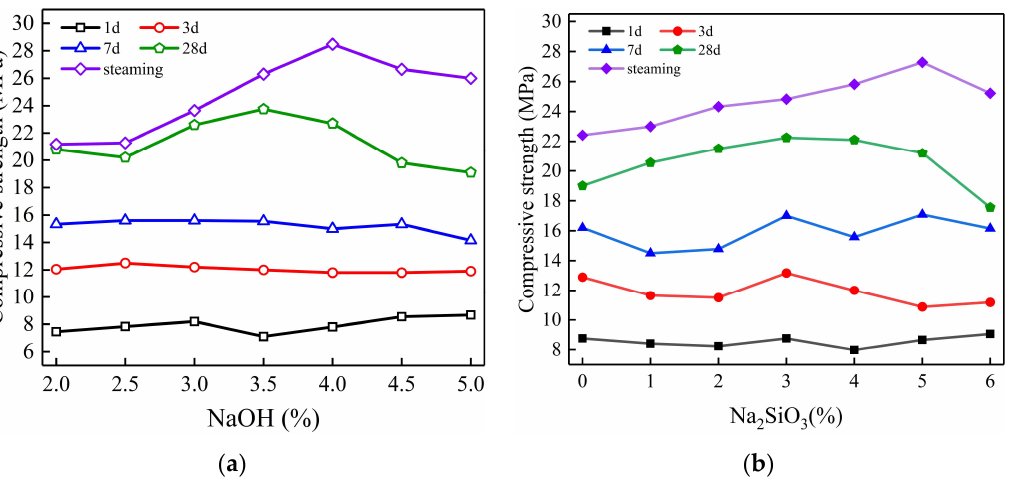
Figure 13. Effect of alkali activator on compressive strength. ( a ) Effect of NaOH content; ( b ) Effect of Na 2 SiO 3 content.